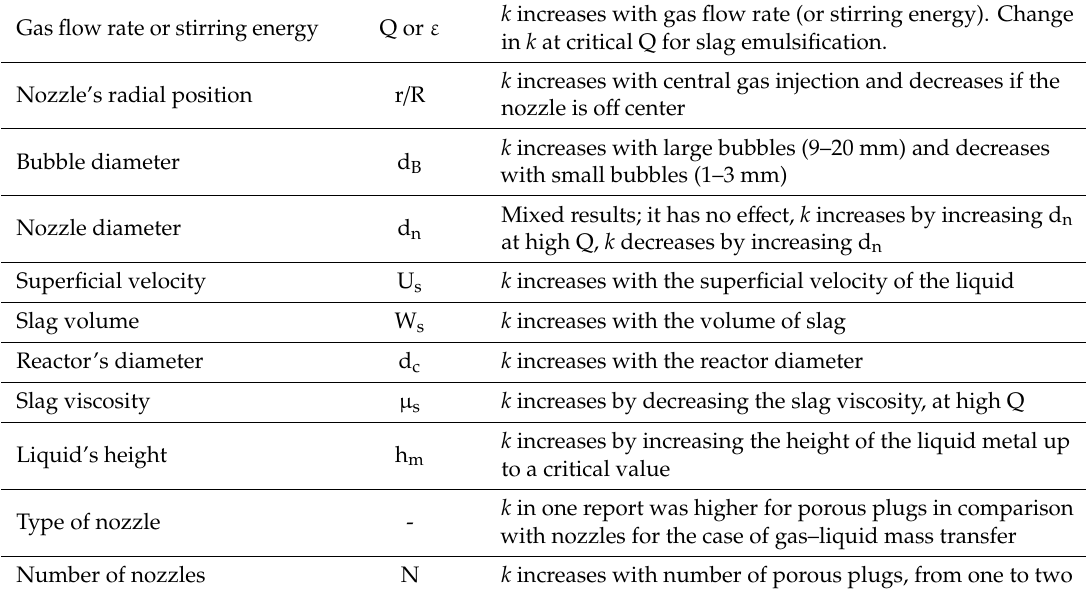
Table 3. Effect of process variables on the mass transfer coefficient ( k ) due to bottom gas injection in ladles. k increases with gas flow rate (or stirring energy). Change Gas flow rate or stirring energy Q or ε in k at critical Q for slag